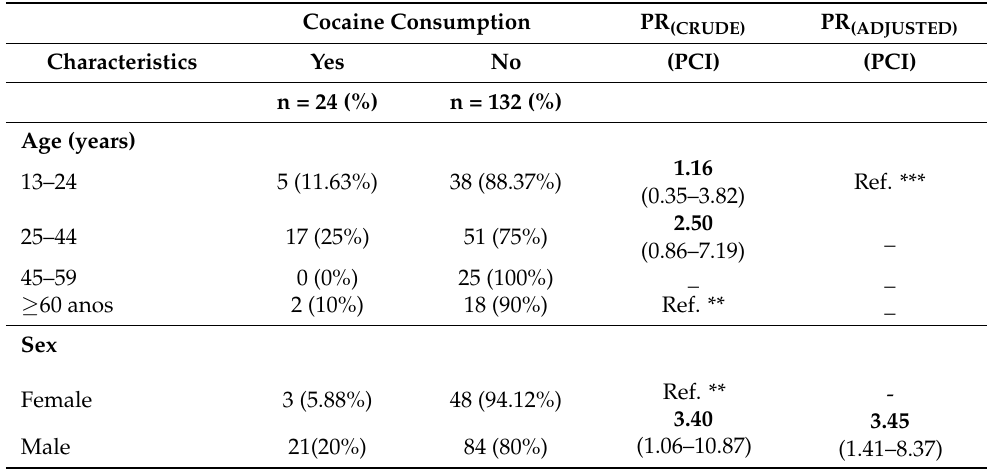
Table 3. Factors associated with cocaine use in suicide